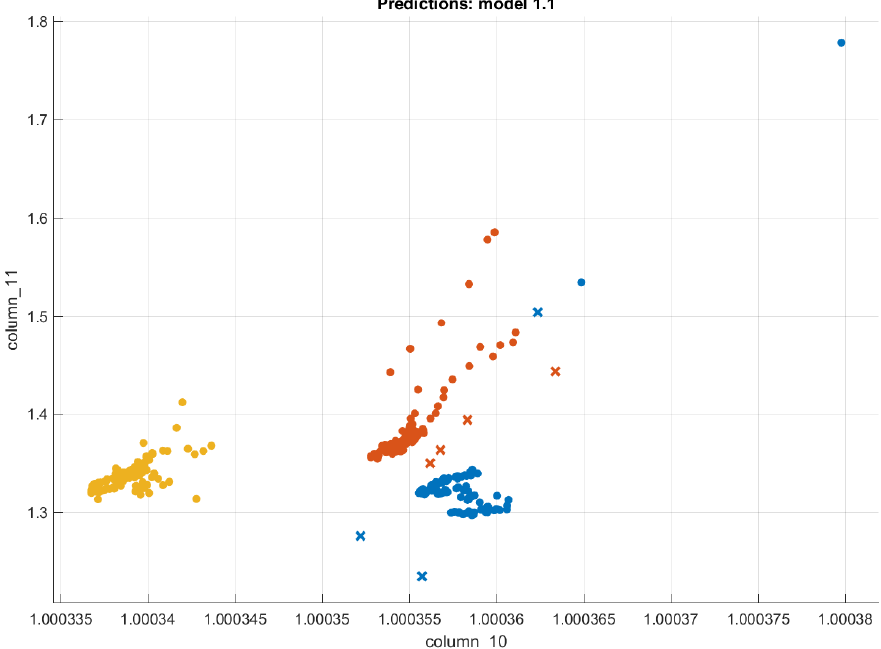
Figure 4. Obtained scatter plot after training the model with new features (1st group of data; yellow – 1st type, orange – 2nd type, blue – 3rd type; • as correct classification, × as misclassification) .